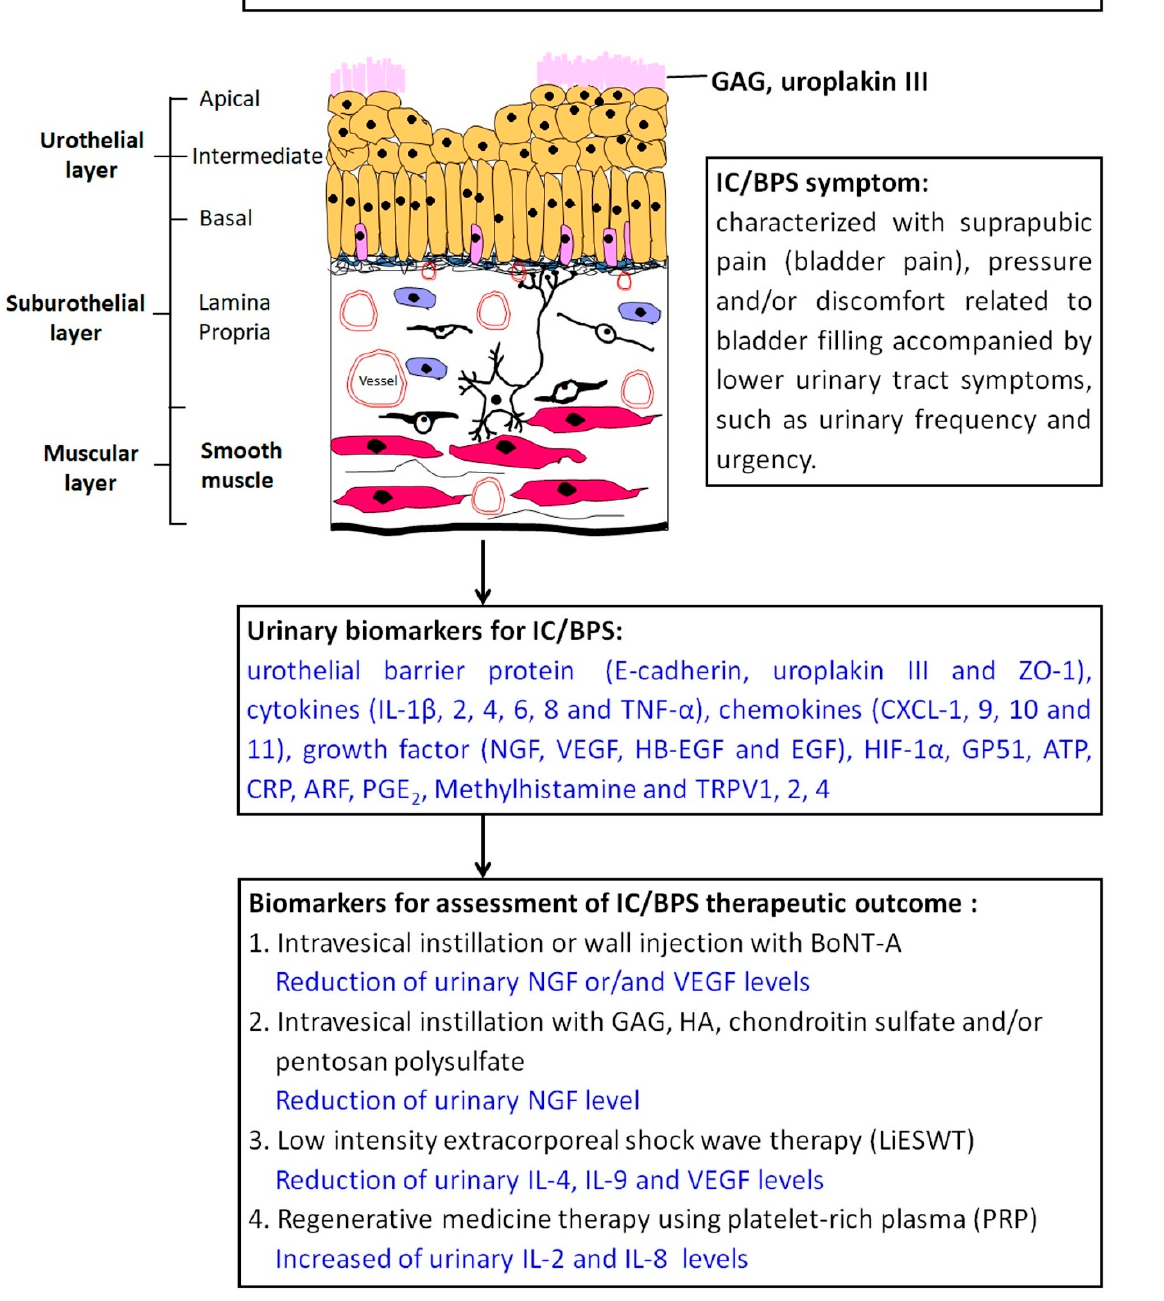
Figure 1. Urinary biomarkers in interstitial cystitis/bladder pain syndrome and its impact on therapeutic outcome. Note: APF, antiproliferative factor; ATP, adenosine triphosphate; CRP, C-reactive protein; CXCR, CXC chemokine receptor; CXCL, CXC chemokine ligand; EGF, epidermal growth factor; FGF, fibroblastic growth factor; GAG, glycosaminoglycan; GP51, glycoprotein 51; HA, hyaluronic acid; HB-EGF, heparin-binding epidermal growth factor; HIF-1 α , hypoxia-inducible factor-1- α ; IC/BPS, interstitial cystitis/bladder pain syndrome; IL, interleukin; NGF, nerve growth factor; PGE 2 , prostaglandin E 2 ; TNF- α , tumor necrosis factor- α ; TRPV, TRP vanilloid; VEGF, vascular endothelial growth factor; ZO-1, zonula occludens-1.